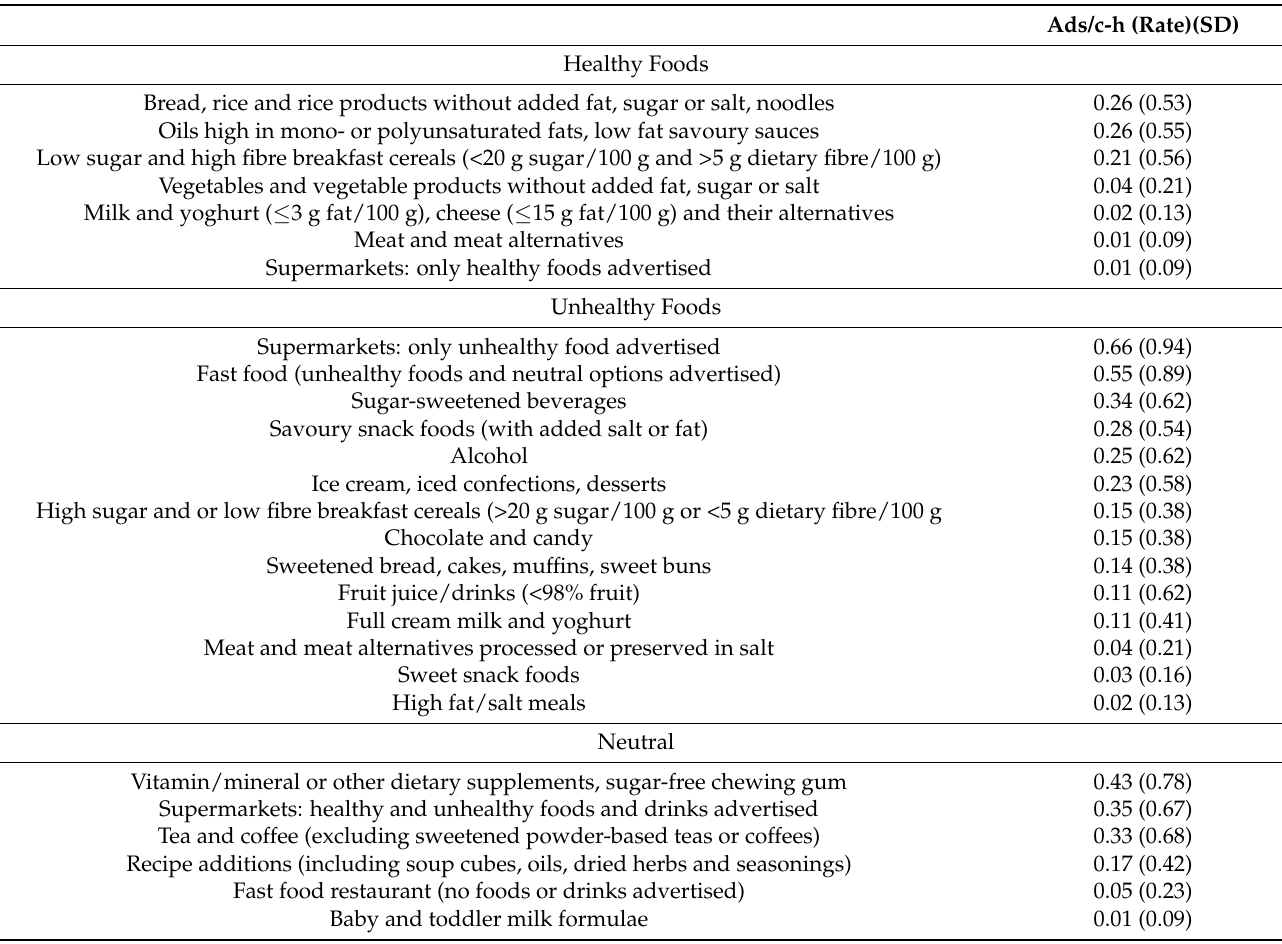
Ads/c-h (Rate)(SD)